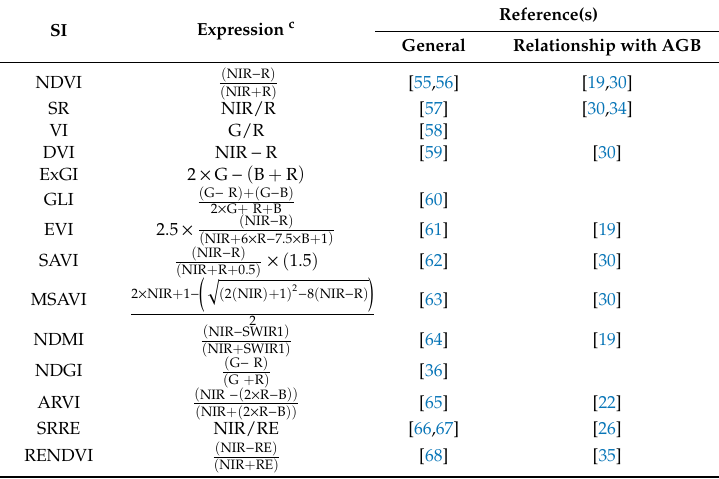
Contrast and dissimilarity indicate the amount of local grey level (GL) variation in an image. Large values indicate the presence of edges, N − 1 (cid:80) (cid:12) (cid:12) (cid:12) (cid:12) p i, j × (cid:12) i − j (cid:12) noise or wrinkled features.Dissimilarity i, j = 0 Measures the smoothness (homogeneity) of the GL distribution of an image. ASM measures the degree of orderliness of pixel values in an image. √ ASM Energy is a measure of uniformity. It measures the degree of randomness of pixel values in an image. Entropy is inversely related to uniformity. Mean of GL distribution of the image. GLCM variance is a measure of the dispersion of GL distribution. Correlation indicates the linear dependency of GL on their neighboring pixels.